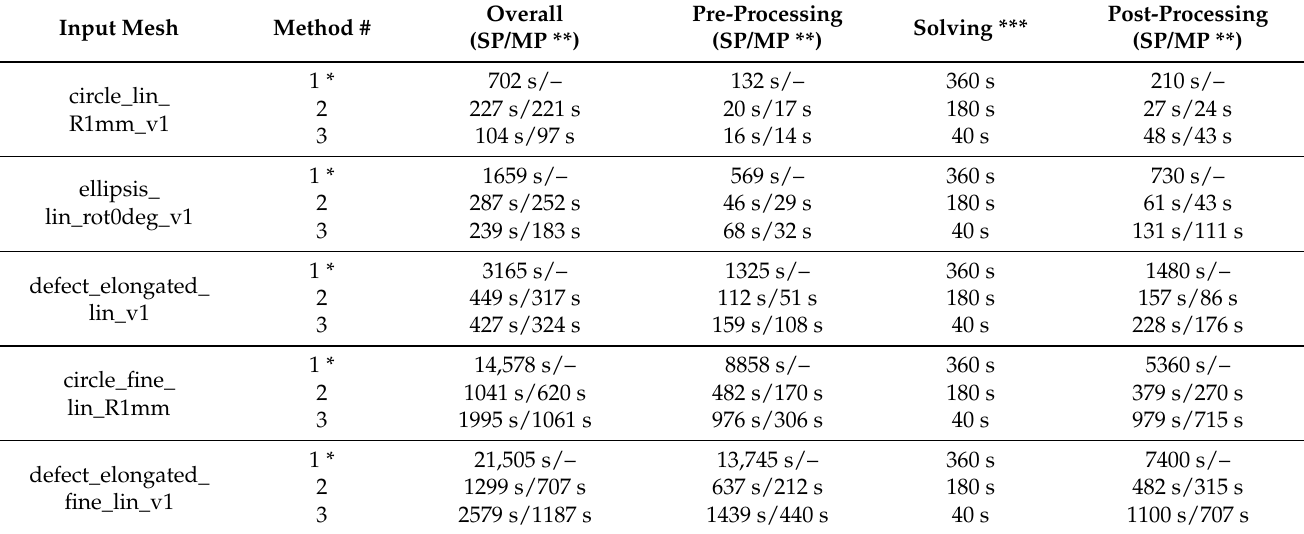
Table 12. Time effort for pre-processing, solving, and post-processing of three characteristic defect geometries using single- and multi-core processing for load vector step of ∆ ϕ = 10 ◦